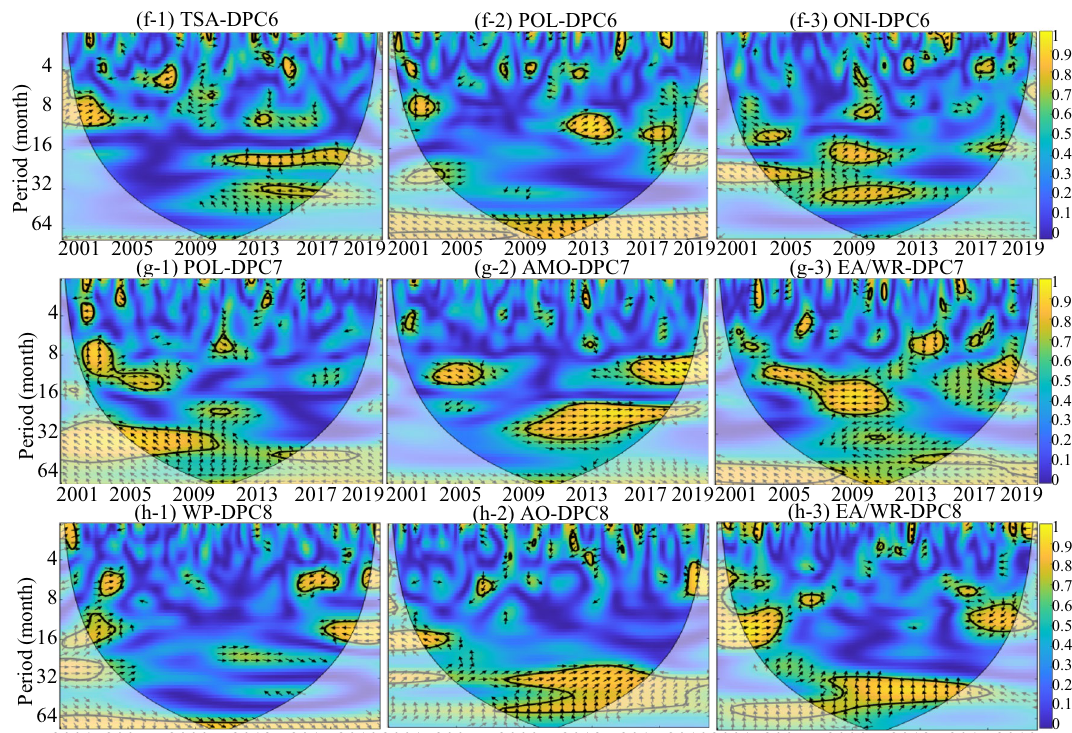
Figure 7. Squared wavelet coherence between the global climatic drivers and the temporal patterns of DPC6–8 (coherence coefficient between the global climatic drivers and DPCs). The black contour designates the 95% confidence level against red noise, and the COI, where edge effects might distort the picture, is shown as a lighter, paler shade. In addition, the phase lags are illustrated by black arrows. The y-axis represents the coherence period, and the color represents the level of the coherence coefficient. This figure was generated using MATLAB version R2020b (https:// jp. mathw orks. com/). The data used in the calculation comes from Fire CCI v5.1 dataset (https:// geogra. uah. es/ fire_ cci/ firec ci51. php) and NOAA (https:// psl. noaa. gov/ data/ clima teind ices/